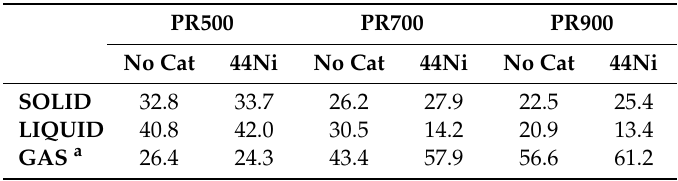
Table 5. Pyrolysis yields (wt.%).